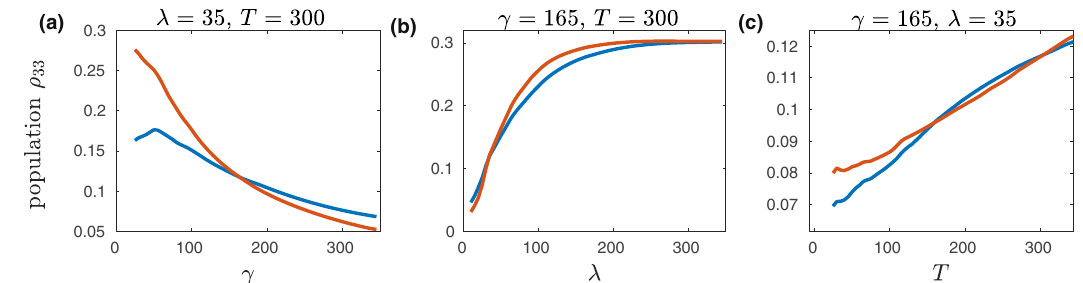
Fig. 4 The evolution of site-3 population at t = 0.5 ps. Plots are shown as a function of ( a ) characteristic frequency of the environment γ ( b ) reorganization energy λ , and c temperature T . The blue line corresponds to the case with initial excition on site-1 while the red line is for the case with initial excition on site-6. γ and λ are in the units of cm − 1 while T is in the units of